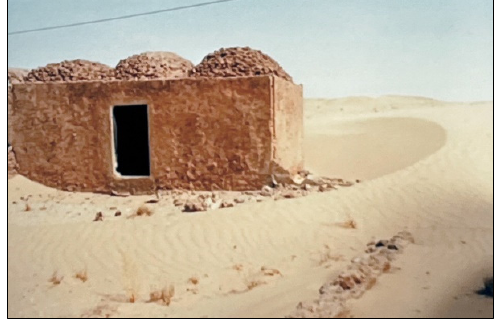
Figure 7. Nezlah house, region of El ‐ Oued Souf, Algeria (photo: M. Sherzad).